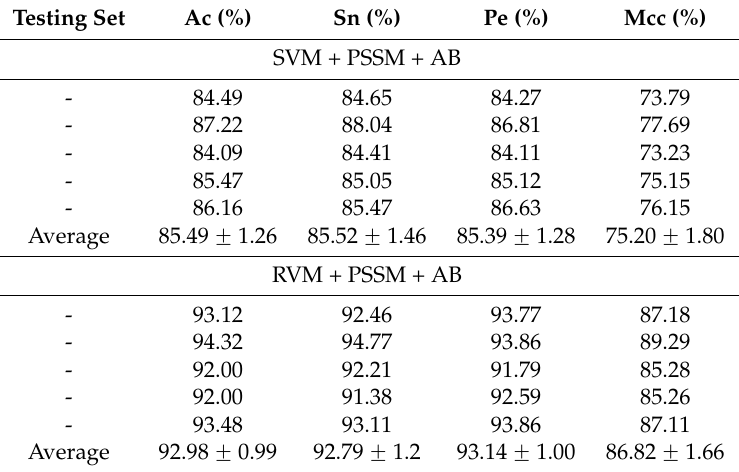
Table 3. Five-fold cross validation results shown using our proposed method on yeast dataset. SVM: Support Vector Machine; PSSM: Position Specific Scoring Matrix; AB: Average Blocks; RVM: Relevance Vector Machine.